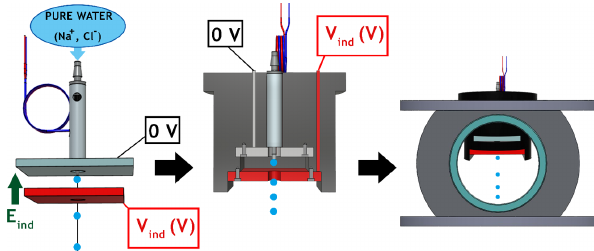
Figure 5. (Left) Electrostatic inductor below the piezoelectric droplet generator. (Centre) Cross section of the housing made with a 3D printer that holds the droplet generator. (Right) Injection head at the top of the In-CASE chamber containing the housing made with a 3D